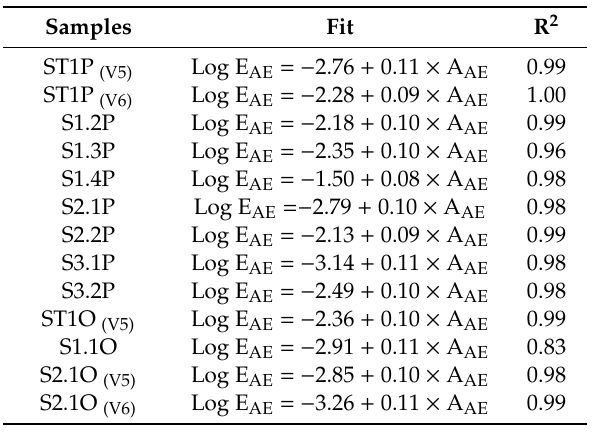
Table A1. Equations of best fit curves shown in Figure A1a,b, referring to the brittle state of tested specimens.